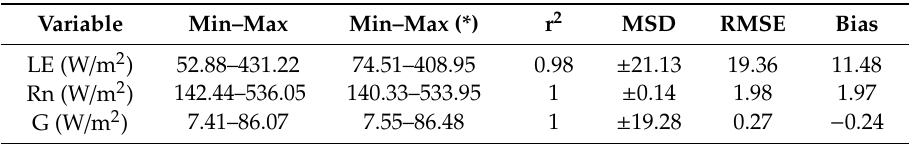
Table 5. Comparison between energy fluxes with and without noise in a native grassland (in situ data): Min–Max is minimum and maximum values, r 2 is the coe ffi cient of determination (–), MSD is the mean standard deviation (W / m 2 ), RMSE refers to the Root Mean Square Error (W / m 2 ); and Bias is the tendency of the model (W / m 2 ).